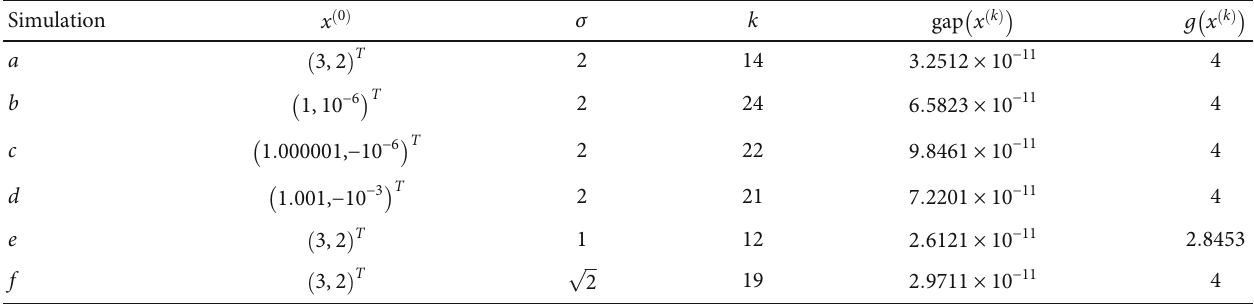
Table 2: Experiment 1: results of problem (7), given by Algorithm in